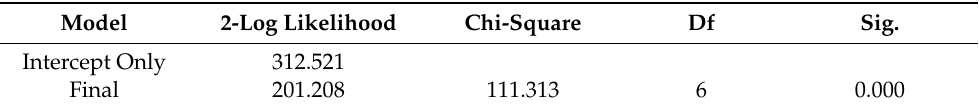
Table 5. Model fit.